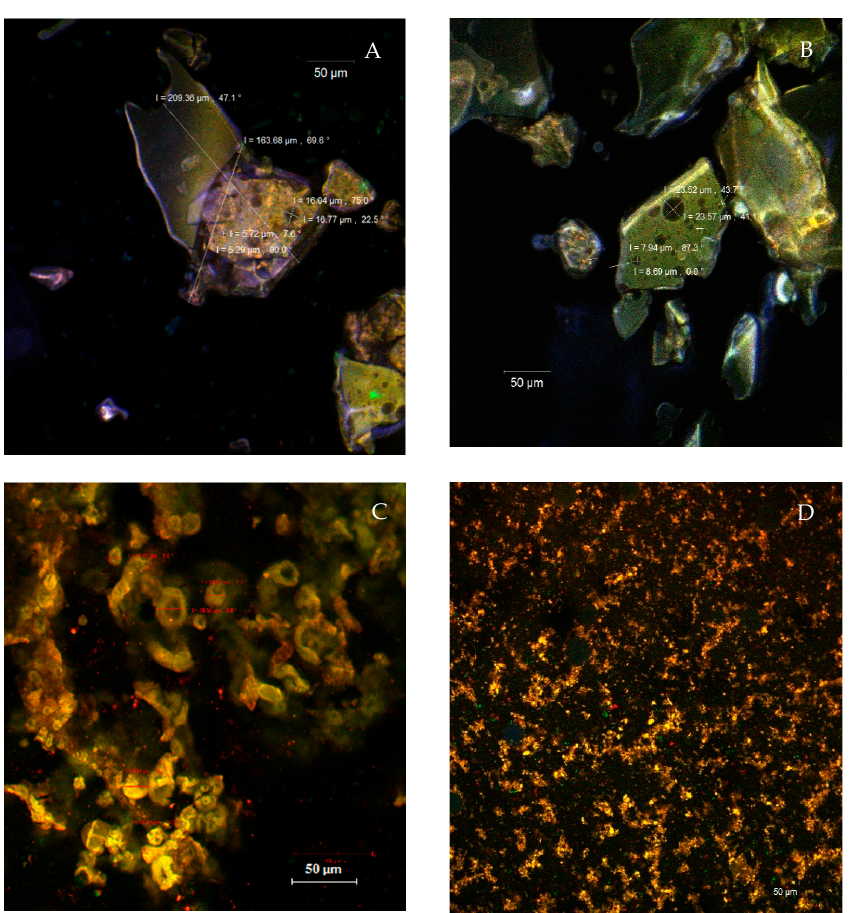
Figure 2. The confocal laser scanning microscopy (CLSM) images (20× apochromatic objective, zoom 1) of the unstained P40 ( A ) and P45 ( B ) native powders and the fluorophore dyed P40 ( C ) and P45 powders ( D ).